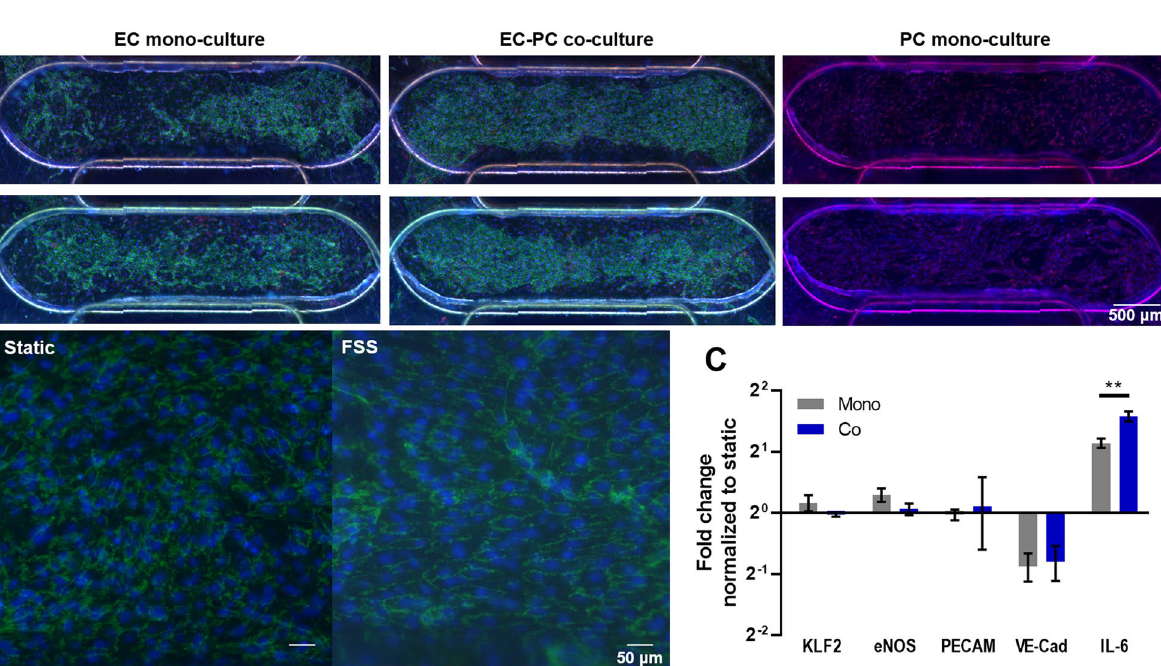
Figure 6. Co-culture model response to inflammatory insult—cytokine profiles from EC channels. Select secreted cytokines in media isolated from the EC channel were analyzed by Luminex, with a comparison of EC mono- vs. EC co-cultures in acute and chronic TNFα stimulation conditions. N = 3 per condition.